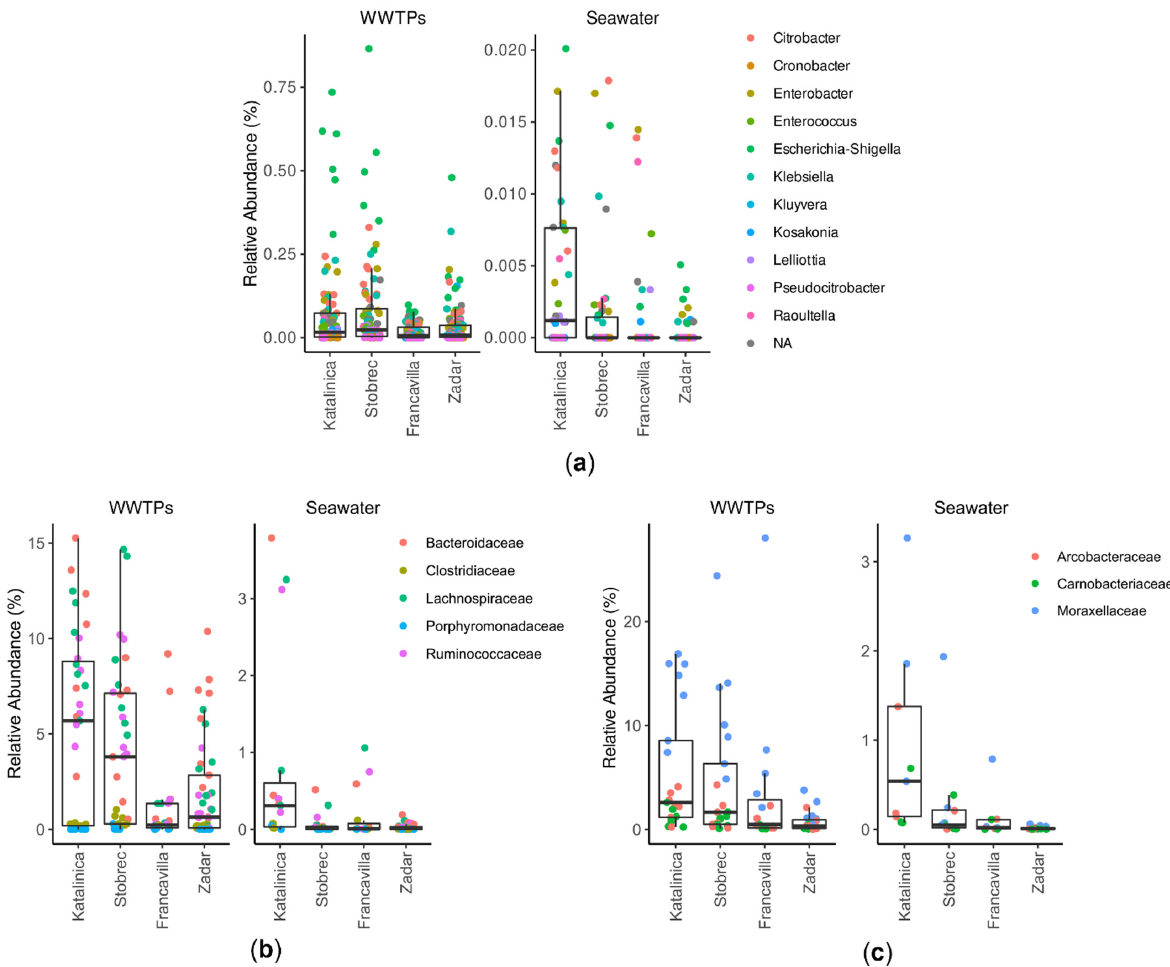
Figure 3. Relative abundances of fecal indicator bacteria in treated sewage (WWTPs) and seawater samples. ( a ) Traditional fecal indicator bacteria (i.e., families Enterobacteriaceae and Enterococcaceae ). ( b ) Alternative fecal indicator taxa: feces-associated families. ( c ) Alternative fecal indicator taxa: sewage-associated genera. Data are the average relative abundance of each taxon over time. Boxplots show the variation of the total relative abundances in each category.